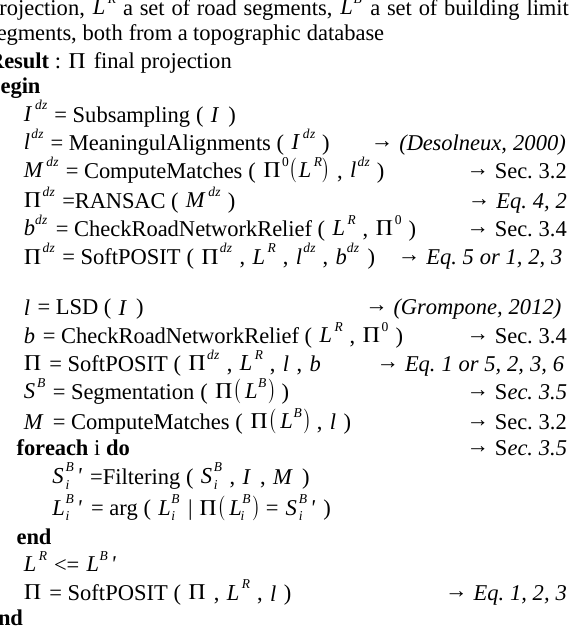
Right : TopoDB projection with model defined in Equation 1 estimated from both roads and buildings Figure 6. Registration of full-resolution image (crop) from Agde dataset (presented in Figure 1 and Table 1). ALGORITHM 1